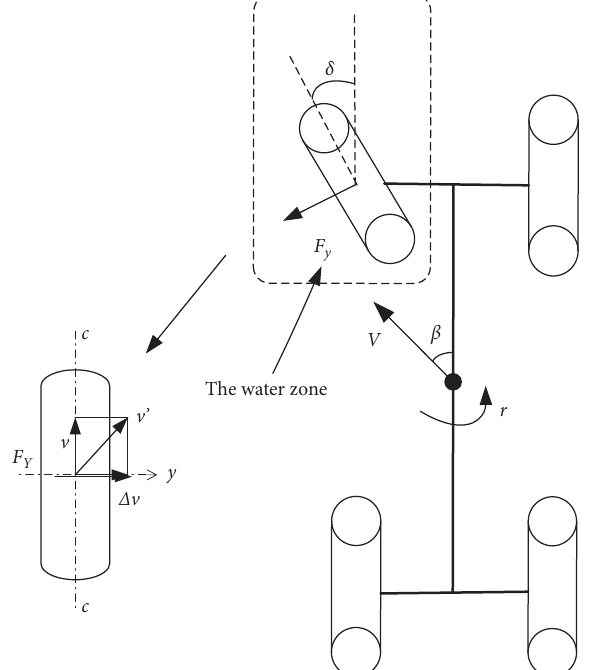
Figure 2: Vehicle dynamics model in water zone.